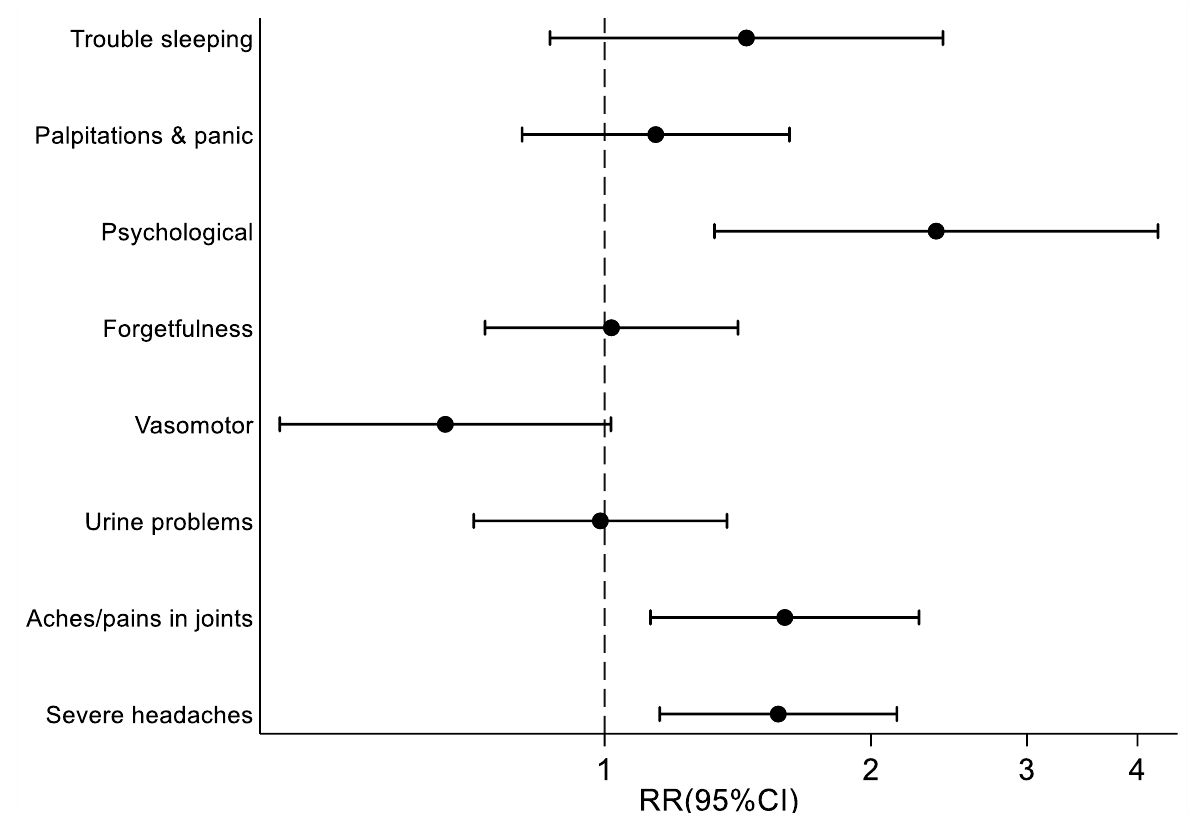
Figure 3. Relationship between individual menopausal symptoms and reporting difficulties coping with menopausal symptoms at work (Adjusted for all significant factors in Tables 1 and 2 + mutual adjustment).